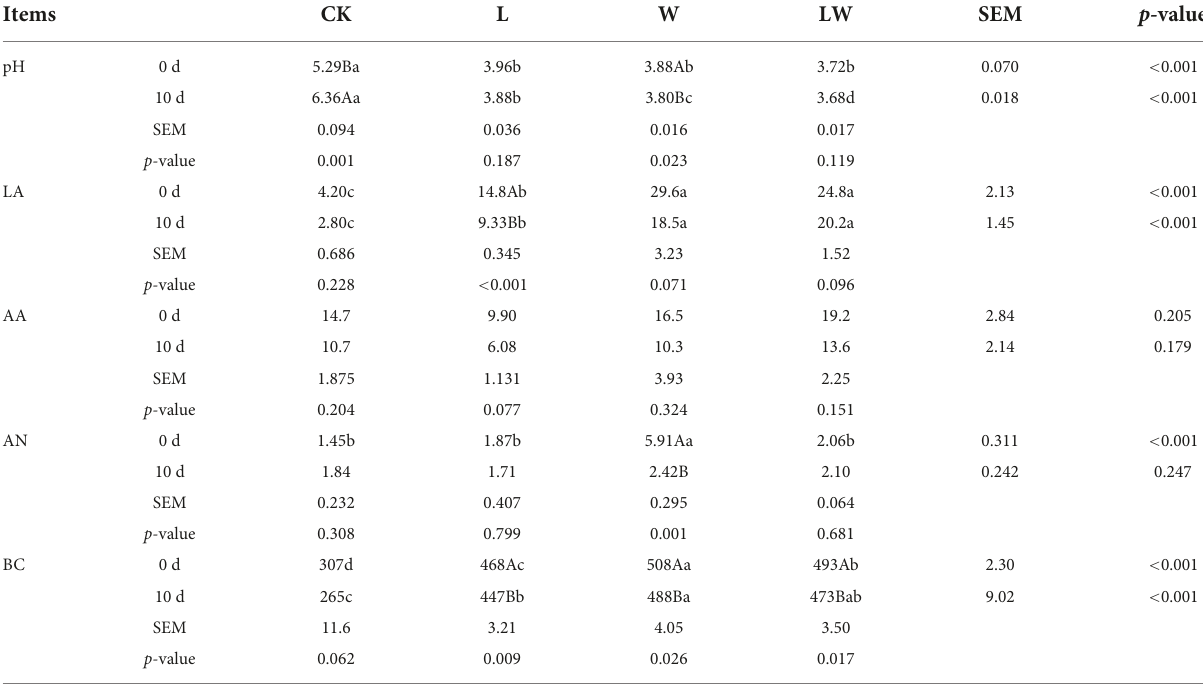
TABLE 2 The pH, organic acid concentrations [g/kg dry matter (DM)], ammonia nitrogen/total nitrogen (AN, g/kg total nitrogen), and buffering capacity (BC, mE/kg DM) in Leymus chinensis silages ( n = 3). Items CK L